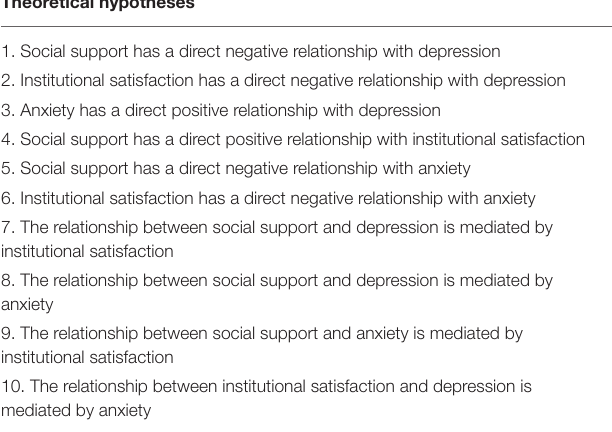
TABLE 1 | The theoretical